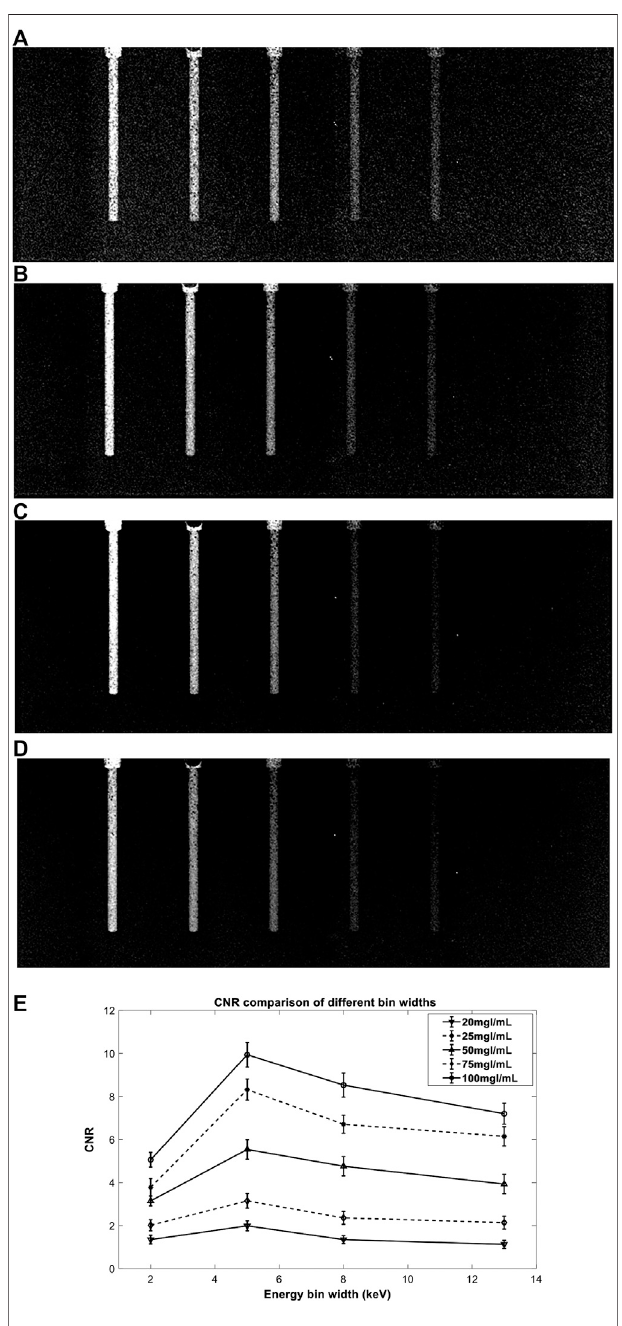
FIGURE11| ComparisonofGSSMdecompositionimageswithdifferent energy bin widths: (A – D) are decomposition images of 2 keV, 5 keV, 8 keV, and 13 keV, respectively; (E) shows comparison of CNR values of different concentrations (100 mg I/ml, 75 mg I/ml, 50 mg I/ml, 25 mg I/ml, and 20 mg I/ml from top to bottom) in the decomposition images.